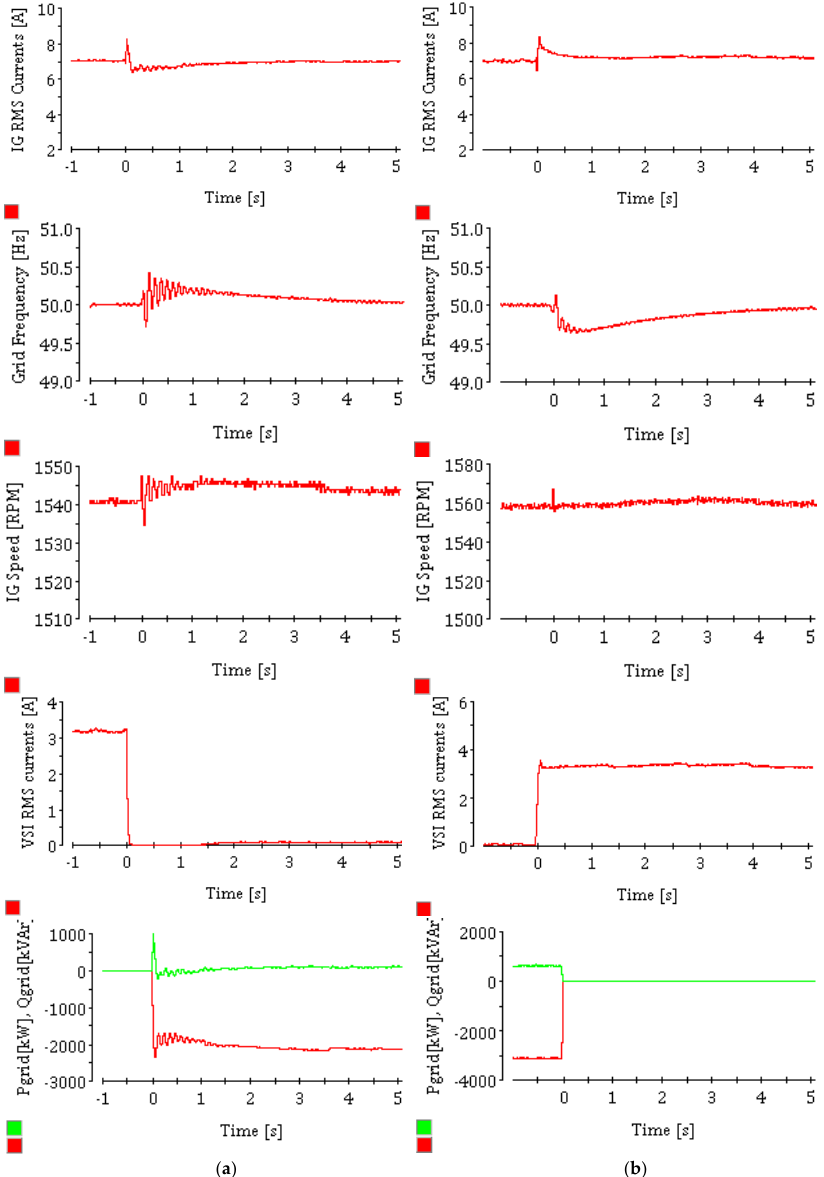
Figure 9. Experimental results for case 1: ( a ) IG system connection to the MG and ( b ) IG system disconnection from the MG.